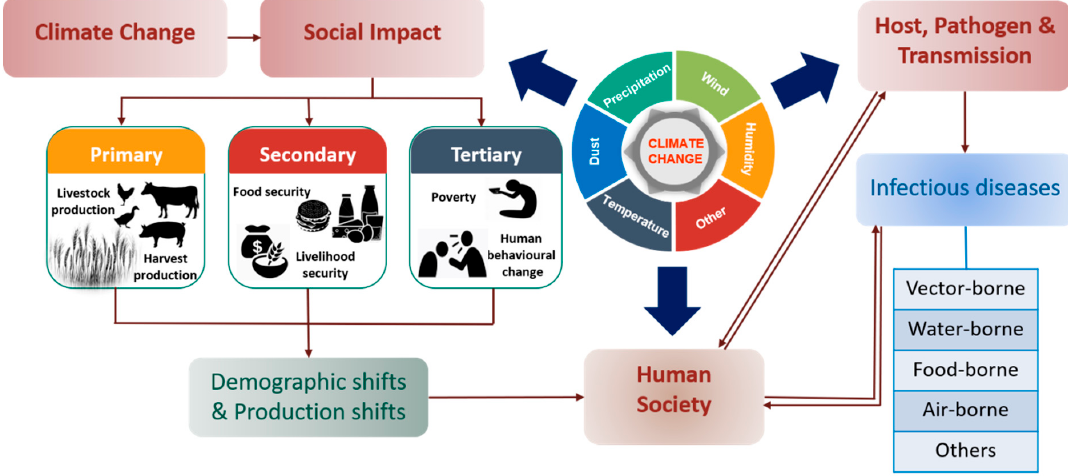
Figure 3. Social impact of climate change affecting livelihood, human society and infectious diseases adapted from [6–10,128–130].